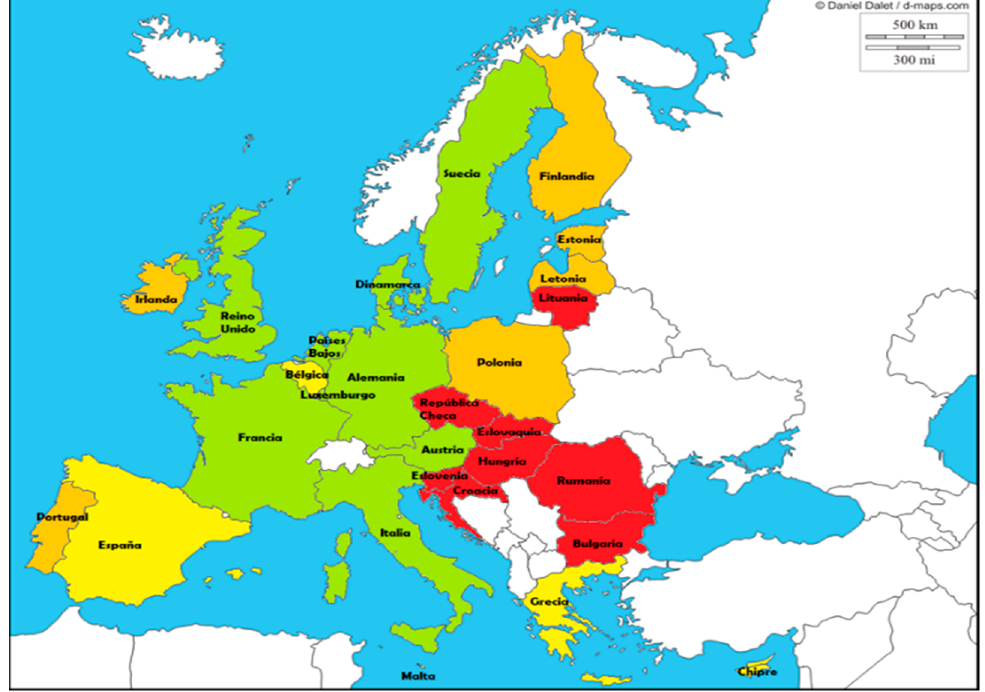
Figure 5. Representation of the 28 countries with one color according to their environmental efficiency with Method 2. Source: own